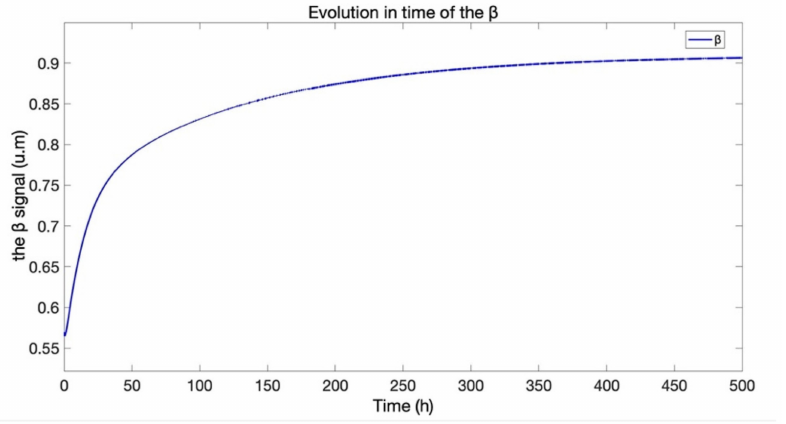
Figure 23. Evolution in time of the β parameter during the running of the adaptive